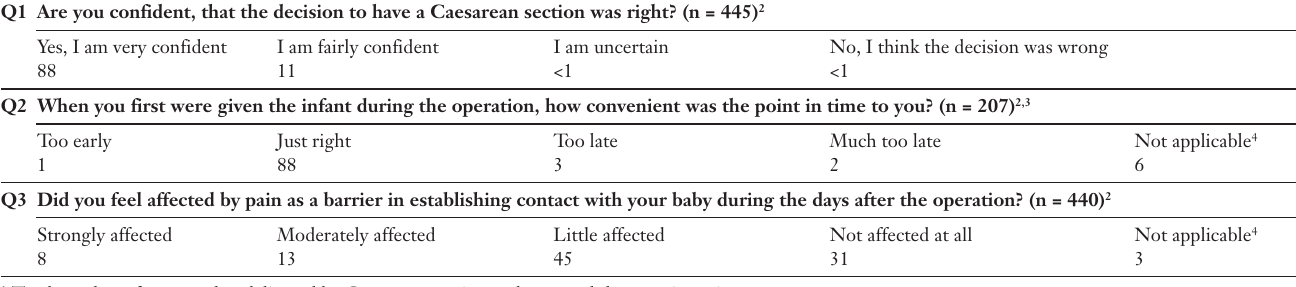
Summary of responses to individual questions related to Caesarean delivery presented in the questionnaire. Values are percentages of patients to whom the question applied and who answered the question. Questions related to delivery by Caesarean section only (n = 459) 1 Q1 Are you confident, that the decision to have a Caesarean section was right? (n = 445) 2